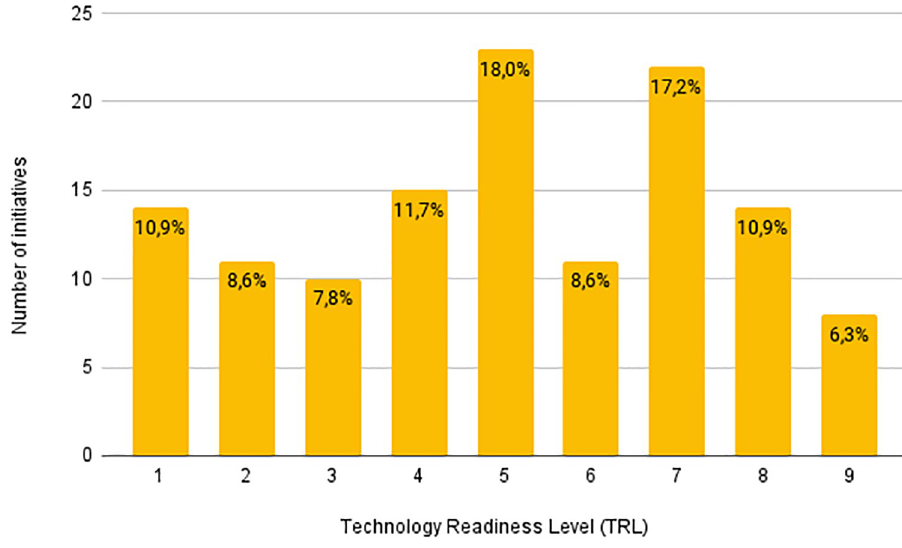
Fig 3. Number of surveyed initiatives for each TRL